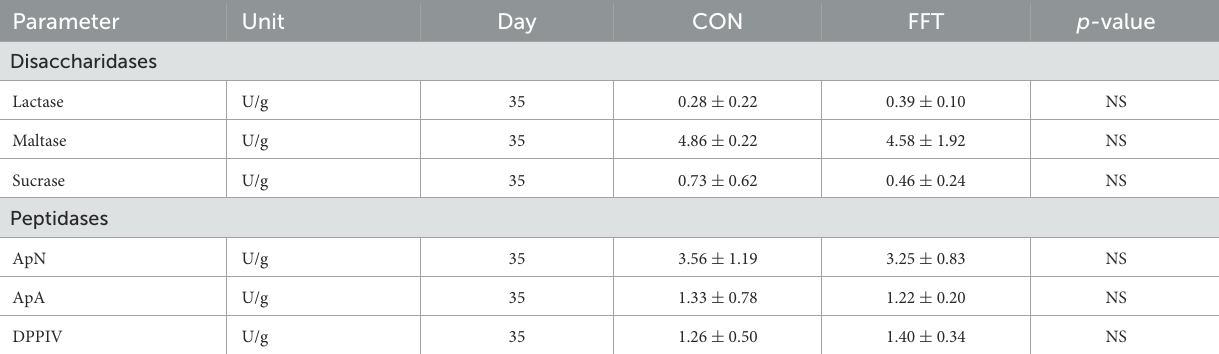
TABLE 11 Gut brush border enzymes of piglets on day 35 ( n = CON: 6; FFT: 8).